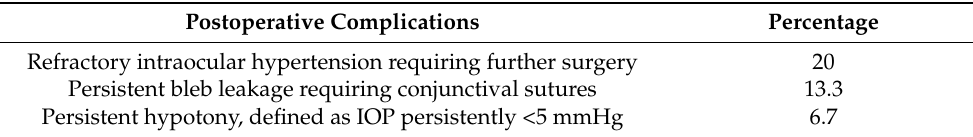
Table 4. Postoperative complications during the